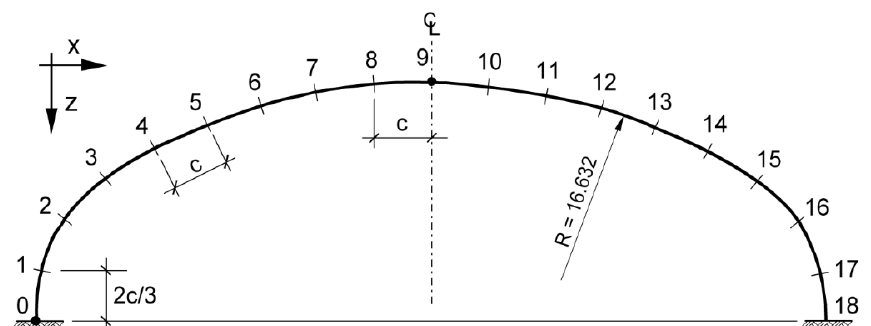
Figure 3: Location of measurement points along the circumferential section of the